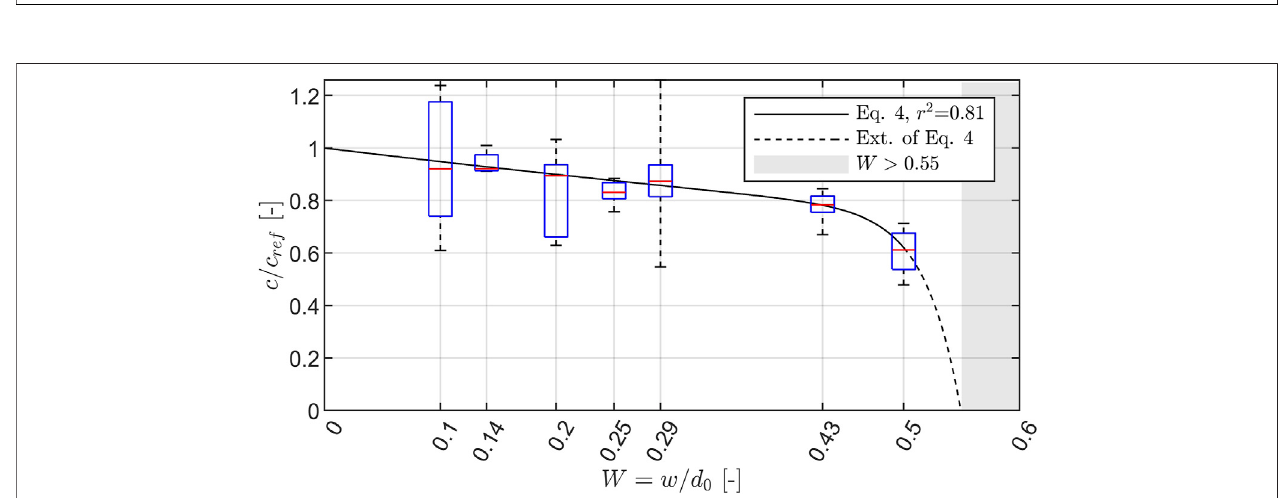
FIGURE 11 | Bore front velocities ( c ) normalized over the corresponding reference front velocities ( c ref , no compound beach present) and averaged over space usingthemedian.Dataareplottedovertheheightofthehorizontalplanenormalizedovertheinitialimpoundmentdepth( W (cid:1) w / d 0 ).Boxplotsarede fi nedasfollows:the median is indicated as a red bar, and the box indicates the 75th and 25th percentile, respectively. Whiskers extend to the most extreme data points. The black solid line representstheapproximationgivenby Eq.4 .Thedashed lineindicatestheextrapolationof Eq.4 .Gray-shadedareacoversvaluesof W largerthan0.55,whereno overland fl ow is